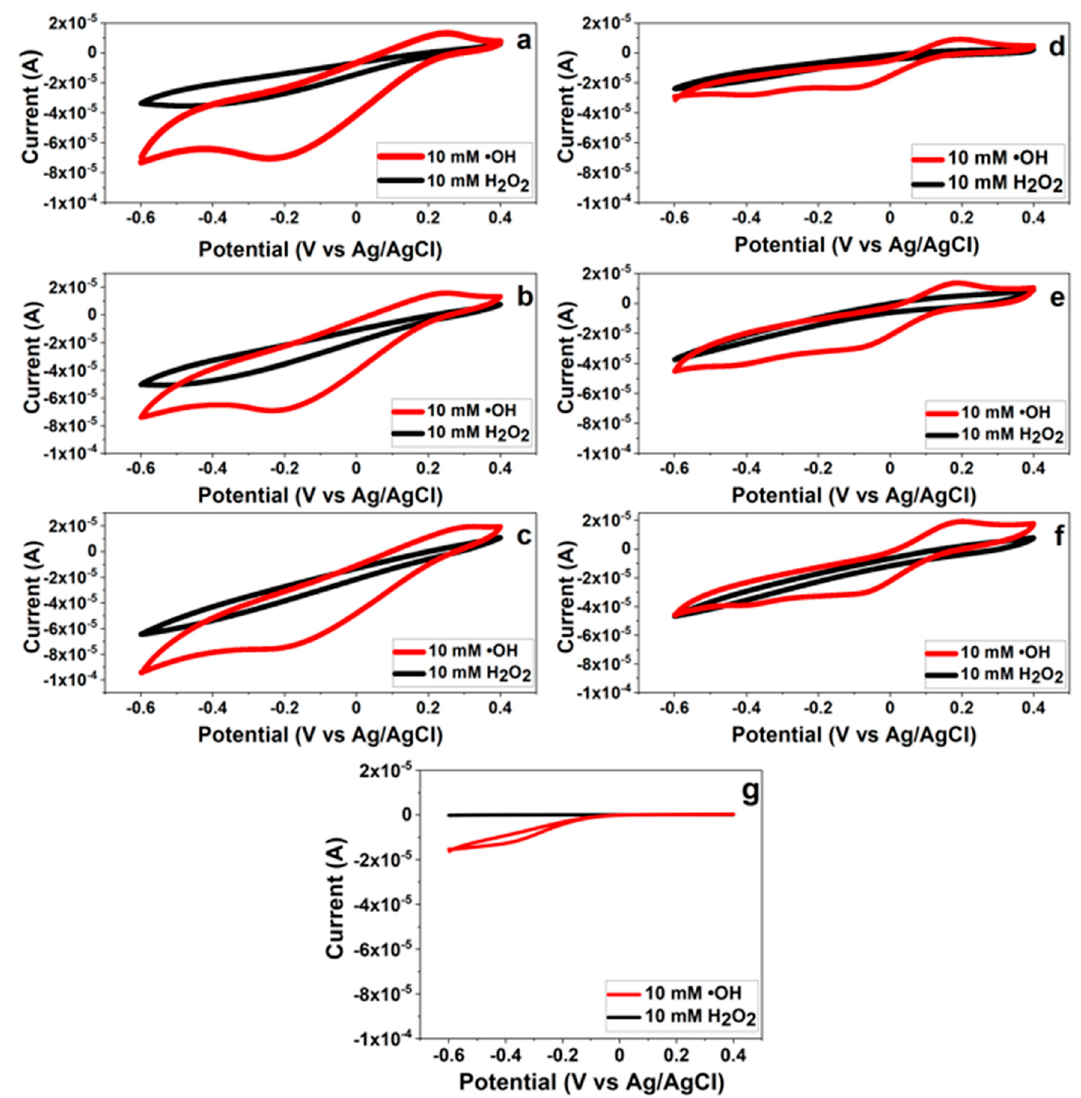
Figure 7. CV responses of ( a , d ) the single layer of CeNP/GO composite with and without the PB modification, ( b , e ) double layers of CeNP/GO composite with and without the PB modification, ( c , f ) triple layers of CeNP/GO composite with and without the PB modification, and ( g ) a bare screen printed carbon electrode (GCE) in the solution contains 10 mM of H 2 O 2 and •OH radicals with the potential range from − 0.6 V to 0.4 V, 100 mV/s.